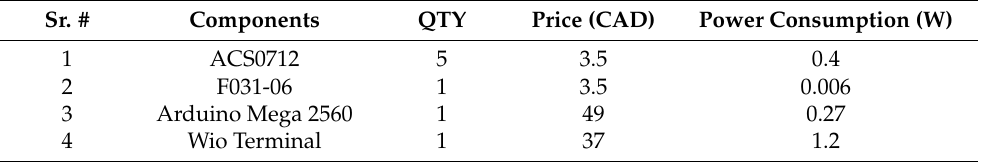
Table 8. Power consumption and price of hardware